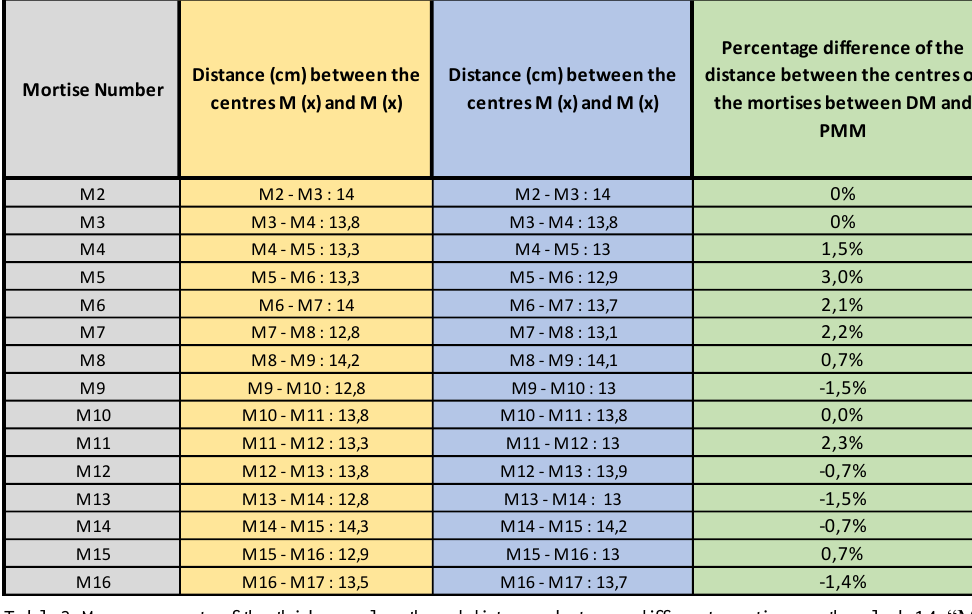
Table 3. Measurements of the thickness, length and distances between different mortises on the plank 14. “M” stands for “mortise”. In yellow, the interpretative drawn measurements (IDM). In blue, the photogrammetry model measurements (PMM). In green, the percentage difference between the IDM and the PMM. The total margin of error of the percentage difference between the IDM and the PMM for the distance between the centres of mortises is of